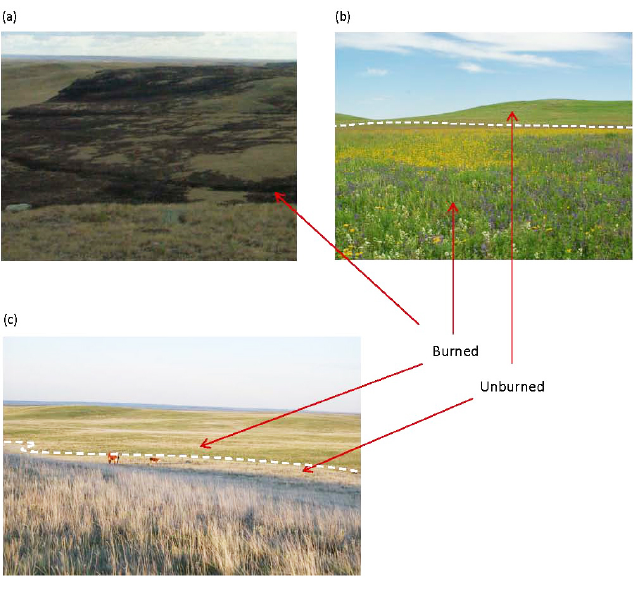
Fig. 1 . Burned and unburned vegetation in East Block of Grasslands National Park of Canada, (a) 2006, (b) 2007, (c) 2008. Dashed white line approximately distinguishes perimeter of burns in 2007 and 2008. The 2006 photo illustrates heterogeneity of burn intensity. (Photos a and b by Robert Sissons; Photo c by Barbara